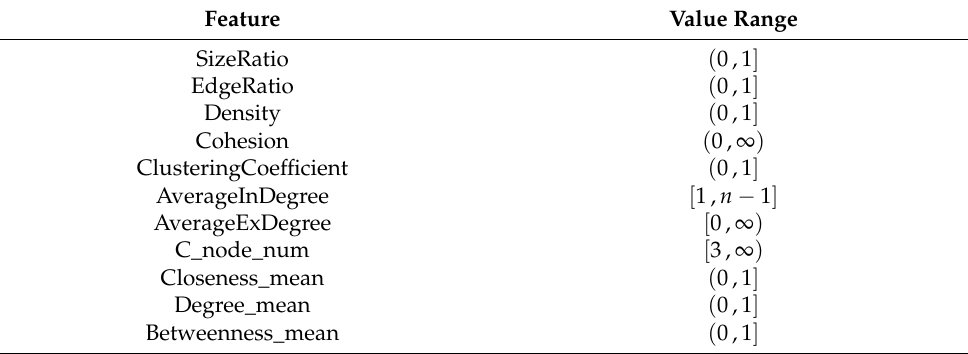
Table 2. Community Structural Features.